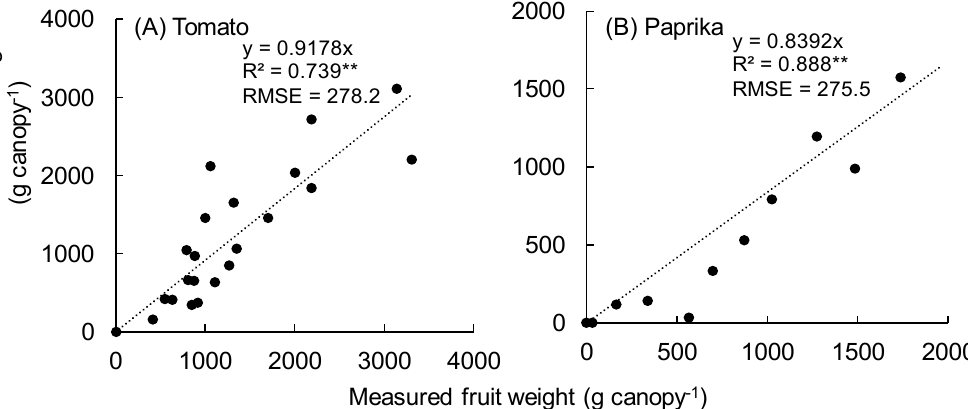
Figure 13. Relationship between the measured and estimated fruit weights. ( A , B ) show the fruit weights of tomato and paprika, respectively. Fruit weight was estimated using the volume calculated by the fruit voxel model and density. Fruit volume was calculated by Meshmixier 3.5 (Autodesk Inc., San Rafael, USA). ** significant at p < 0.01 according to the regression analysis. RMSE means root mean squared error.